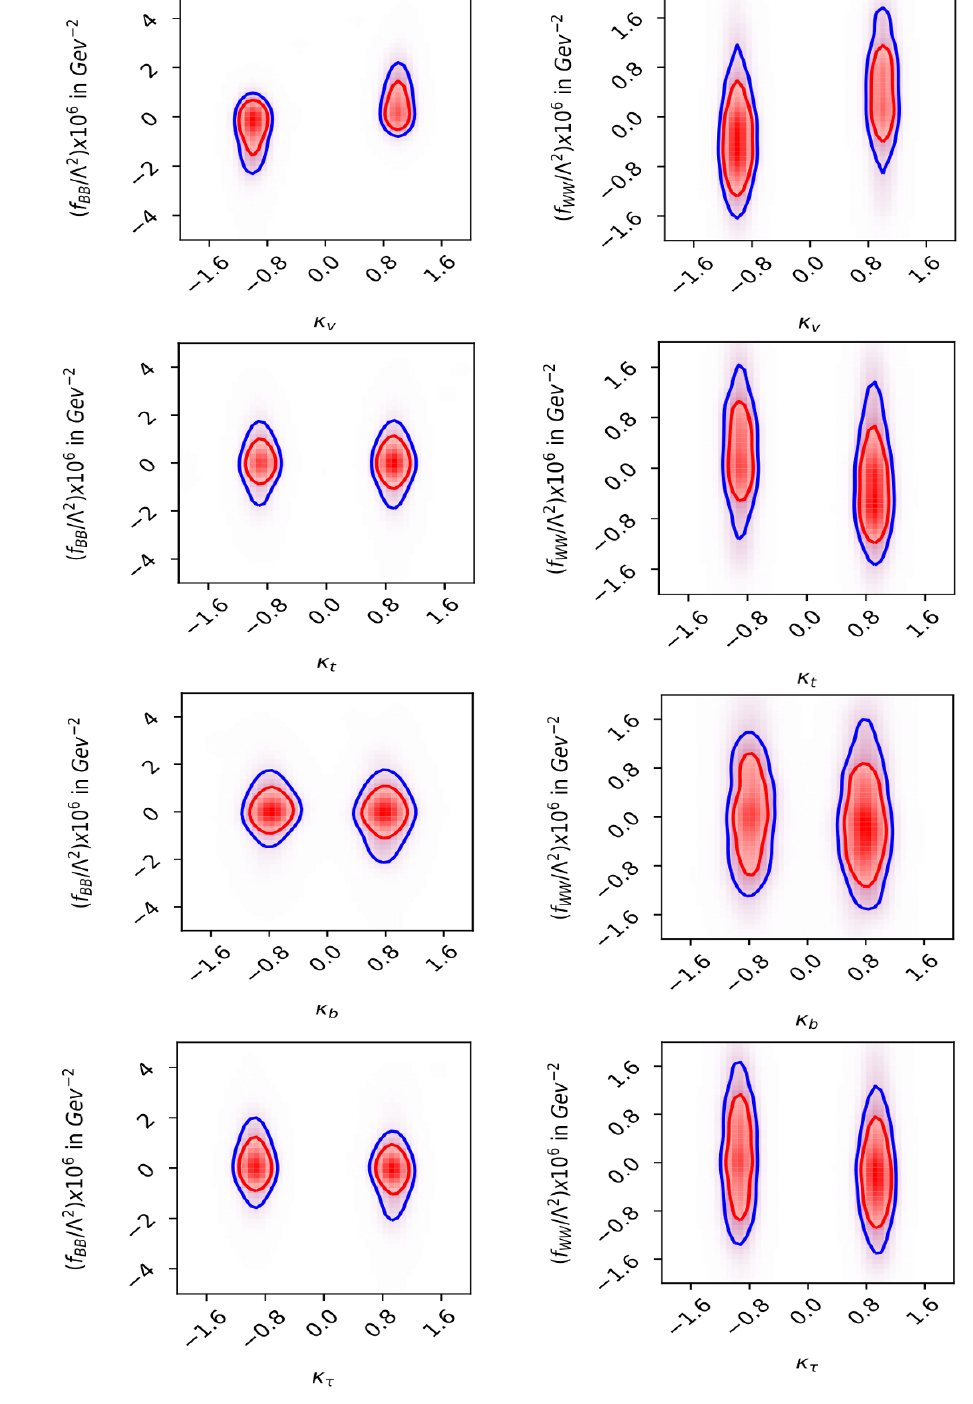
Figure 3 . Allowed regions at 1 (cid:27) (red) and 2 (cid:27) (blue) levels in the parameter space of scale factors and dimension-6 couplings.